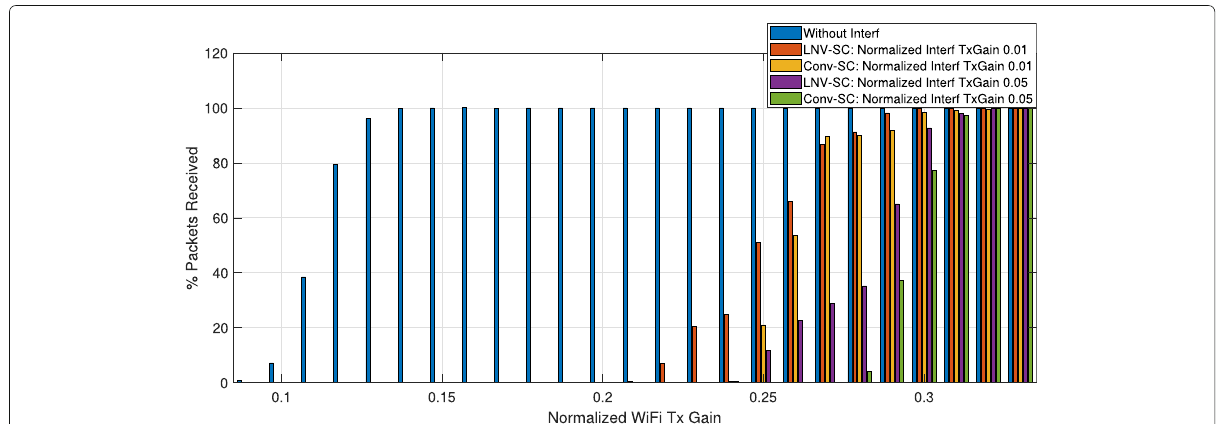
Fig. 19 LNV-SC (proposed method) in the two interferer case also leads to more WiFi frames passing CRC test compared to Conv-SC (conventional method) at a lower WiFi TXP. This is observed for both the experimented interferer TXP normalized transmit gain from 0.0 till all the transmitted WiFi frames were correctly received. As a performance metrics, we chose the percentage of packets received by each method for a given normalized transmit gain of WiFi transmitter.